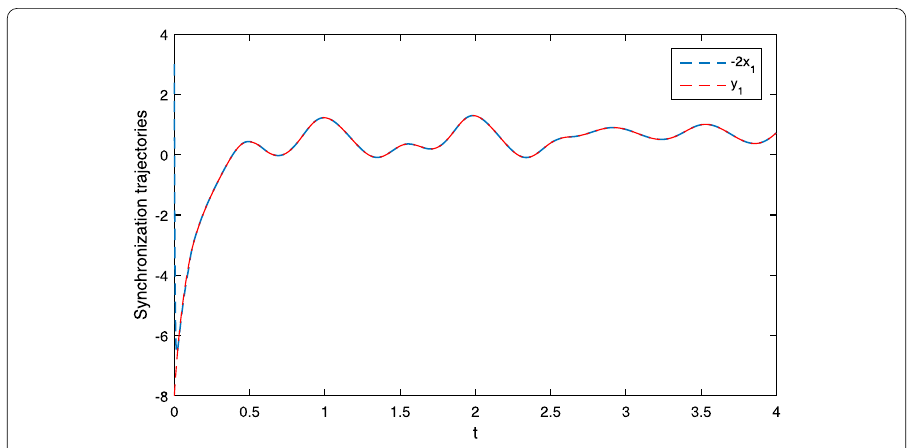
Figure 13 The synchronization trajectories of x 1 , y 1 with β = –2